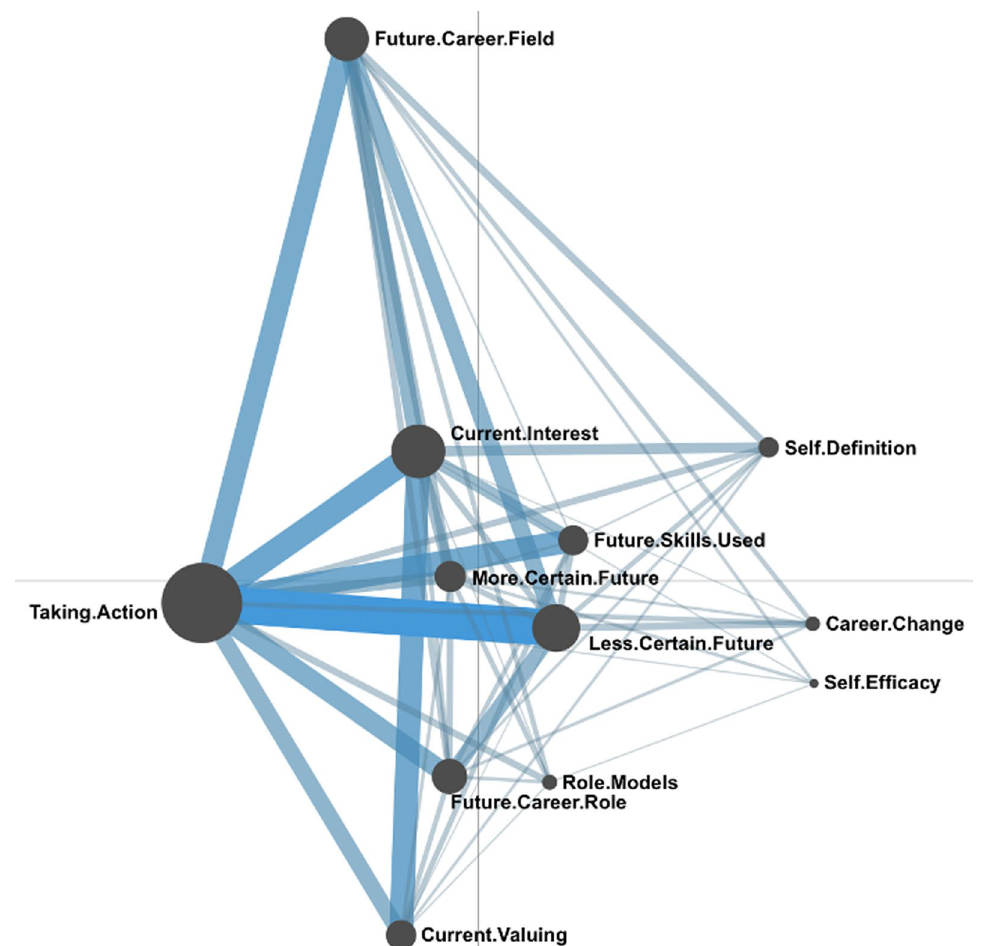
Fig. 1 Epistemic network of associations between identity themes for student